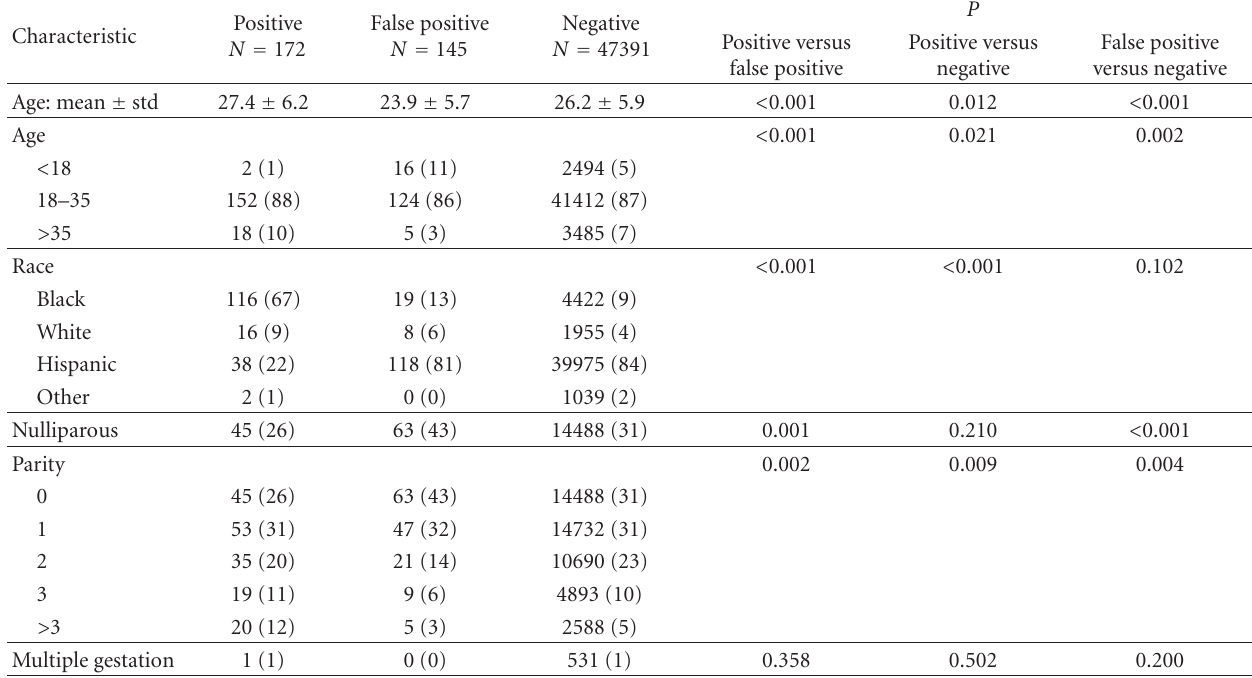
Table 1: Demographic and obstetric characteristics of HIV positive, false positive, and negative women.